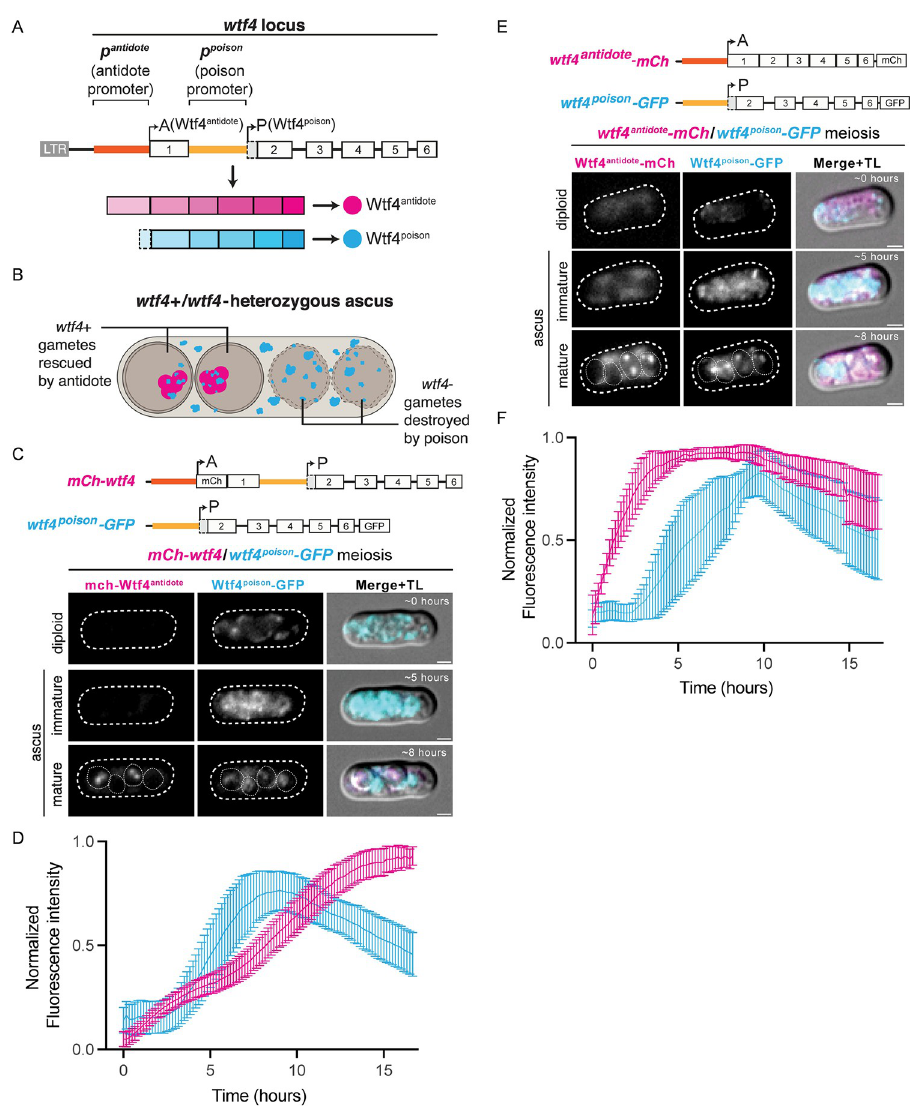
Fig 1. Wtf4 poison and Wtf4 antidote proteins have distinct expression profiles. ( A ) A depiction of the wtf4 gene is shown. There is a Tf retrotransposon LTR located 284 base pairs upstream of exon 1. The sequence upstream of exon 1 contains the antidote promoter, p antidote (in orange) and intron 1 contains the poison promoter, p poison (in yellow). The arrows represent the predicted translational start sites. Wtf4 antidote (magenta circle) is encoded by exons 1–6. Wtf4 poison (cyan circle) is encoded by exons 2–6. ( B ) Model of Wtf4 poison-antidote meiotic drive from wtf4 heterozygotes. Wtf4 poison is present in all four spores, while Wtf4 antidote expression is enriched in only two of the four spores. ( C ) Time-lapse microscopy of an mCherry-wtf4/wtf4 poison -GFP diploid undergoing meiosis and sporulation. mCherry- Wtf4 is shown in magenta and Wtf4 poison -GFP is shown in cyan in merged images. Images of a representative cell from the time lapse shown at ~ 0 hours (diploid), ~5 hours (immature ascus), and ~8 hours (mature ascus) after the video begins. Distinct images for these strains were first presented in [37] and a timelapse following protein movement in mature asci of these strains was presented in [52]. ( D ) Normalized fluorescence intensity plots of Wtf4 poison -GFP (cyan line) and mCherry-Wtf4 antidote (magenta line) over the course of the time lapse (n = 25). ( E ) Time-lapse microscopy of a wtf4 antidote -mCherry/wtf4 poison -GFP diploid undergoing meiosis and sporulation. Wtf4 antidote -mCherry is shown in magenta and Wtf4 poison -GFP is shown in cyan in merged images. Images of a representative cell from the time lapse shown at ~ 0 hours (diploid), ~5 hours (immature ascus), and ~8 hours (mature ascus) after the video begins. ( F ) Normalized fluorescence intensity plots of Wtf4 poison -GFP (cyan line) and Wtf4 antidote -mCherry (magenta line) over the course of the time lapse (n = 13) TL = transmitted light. All scale bars represent 2 μ m. Error bars depict the 95% confidence interval. Time lapse imaging was performed under the same settings. Not all images are shown at the same brightness and contrast to avoid over saturation of pixels in the brighter